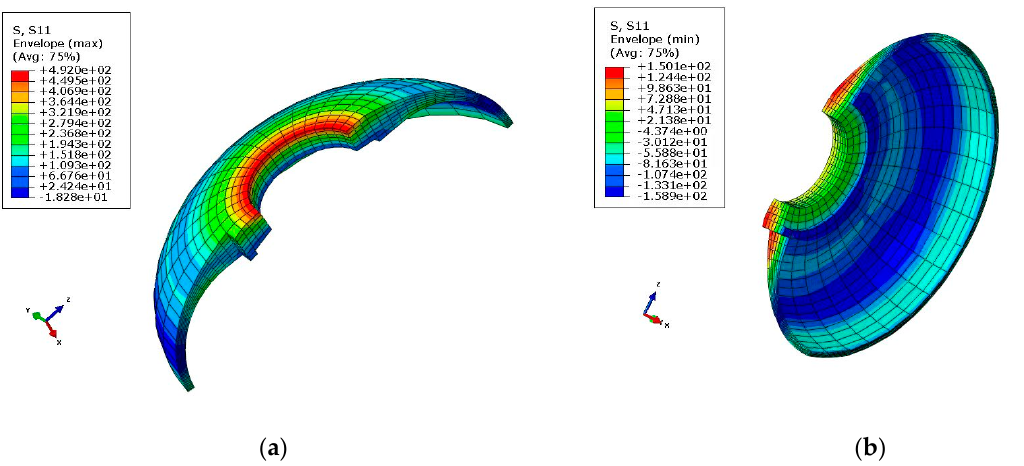
Table 4. Finite element calculation results.